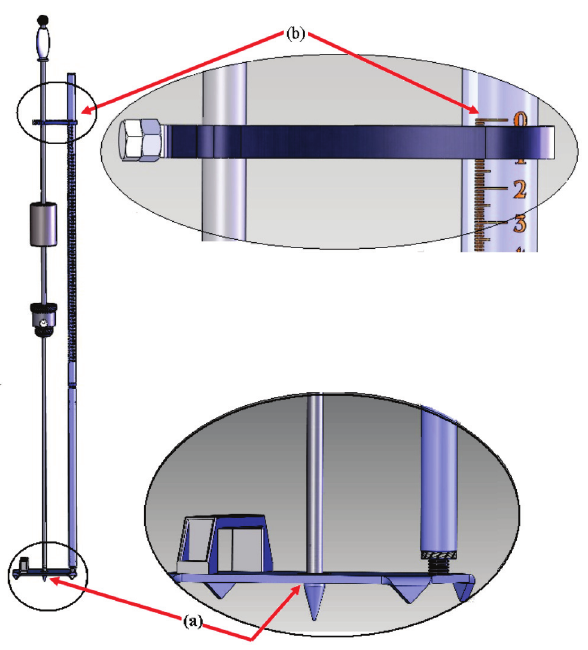
Figura 3. Método atual: medida da profundidade na régua. Posições (a) e (b) para ajustar o zero.